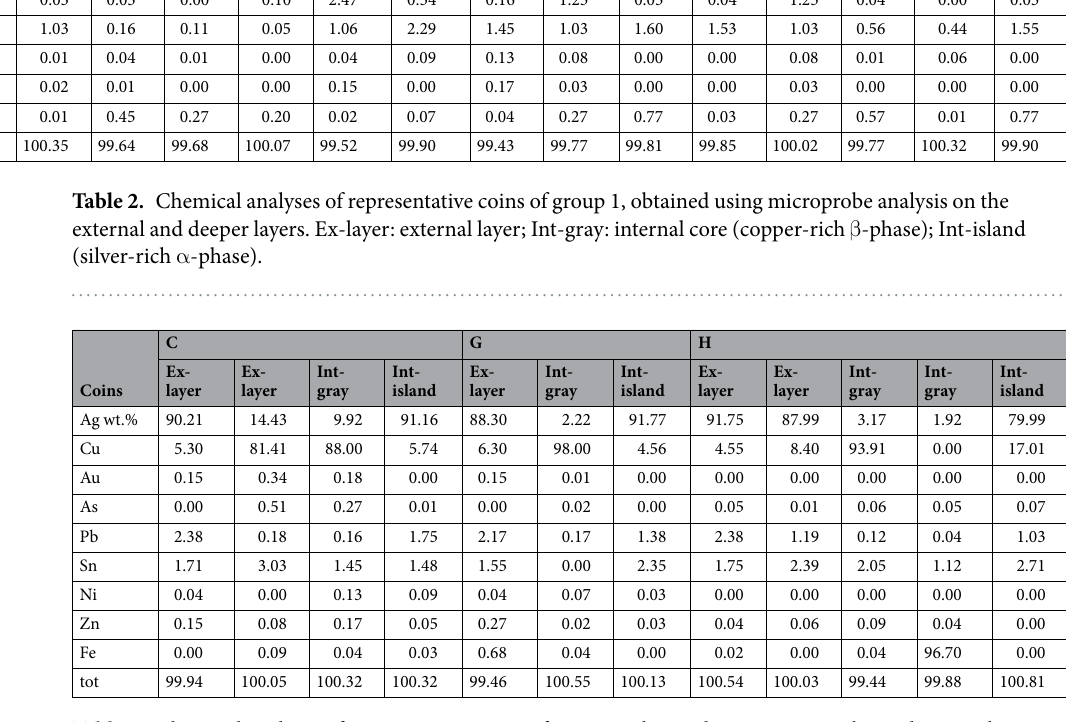
Table 3. Chemical analyses of representative coins of group 2, obtained using microprobe analysis on the external and deeper layers. Ex-layer: external layer; Int-gray: internal core (copper-rich β -phase); Int-island (silver-rich α